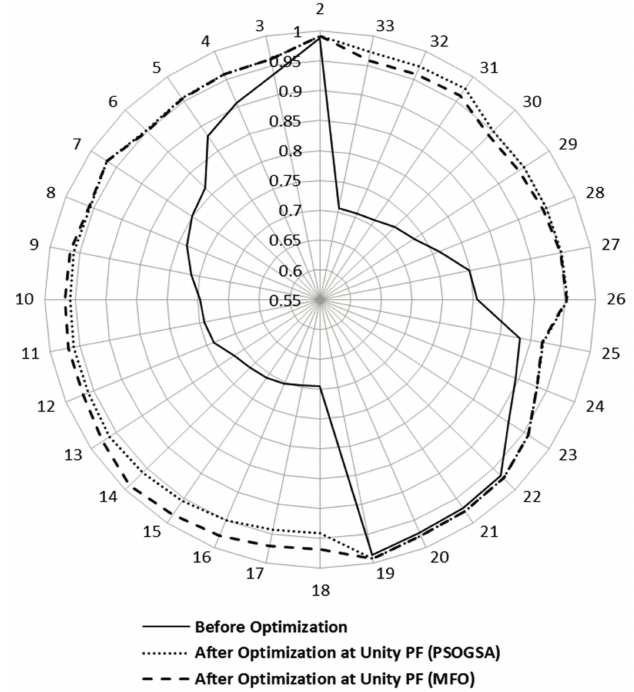
Figure 17. The impact of compensated devices on VSI profile for 33-bus IEEE system at 0.866